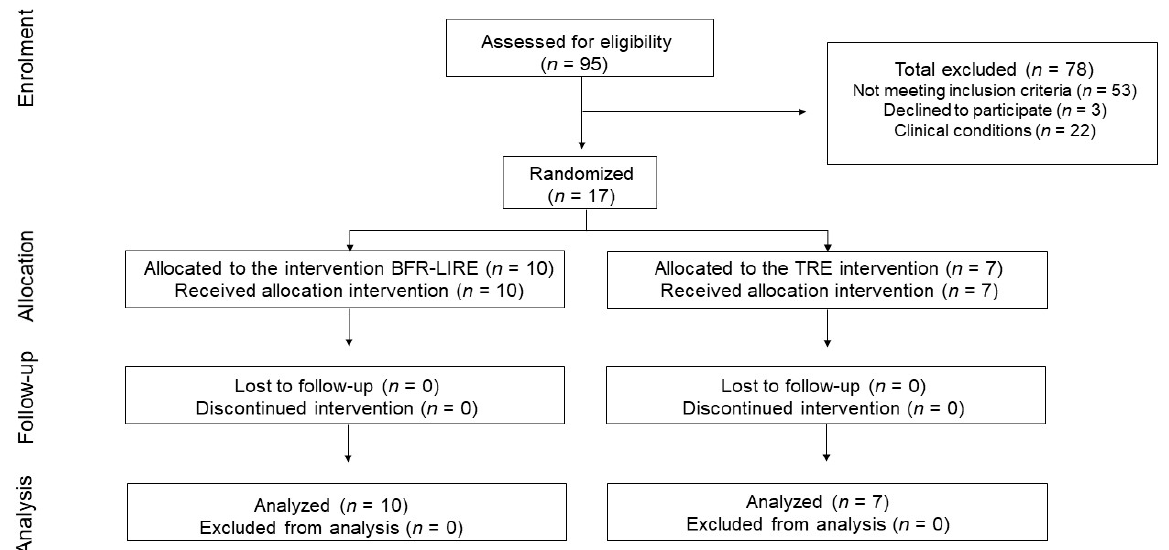
Figure 1. Consort diagram illustrating the number of recruited patients and reasons patients were not included.